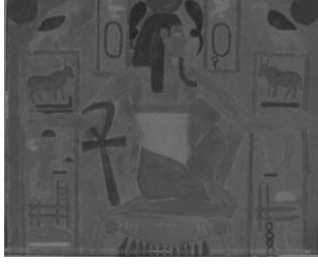
Figure 3. Laser reflection intensity